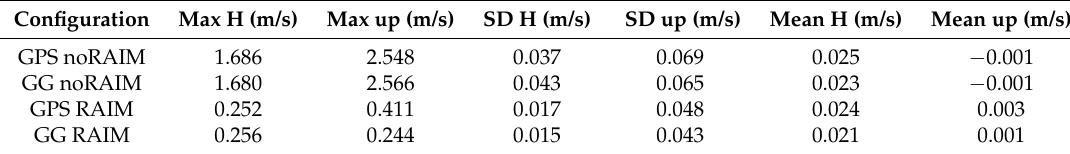
Figure 17. Horizontal velocity errors as a function of time. Upper box: configurations without RAIM; lower box: configurations with RAIM. Table 7. Velocity error statistics considering all